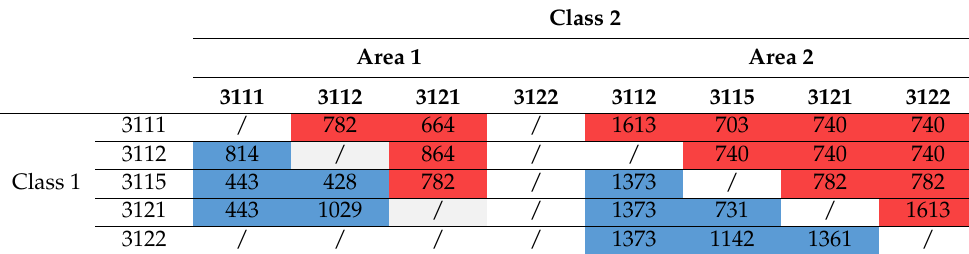
Table 6. Fourth level: best wavelength for two-class separability. In blue, the wavelength extracted from PRISMA; in red from